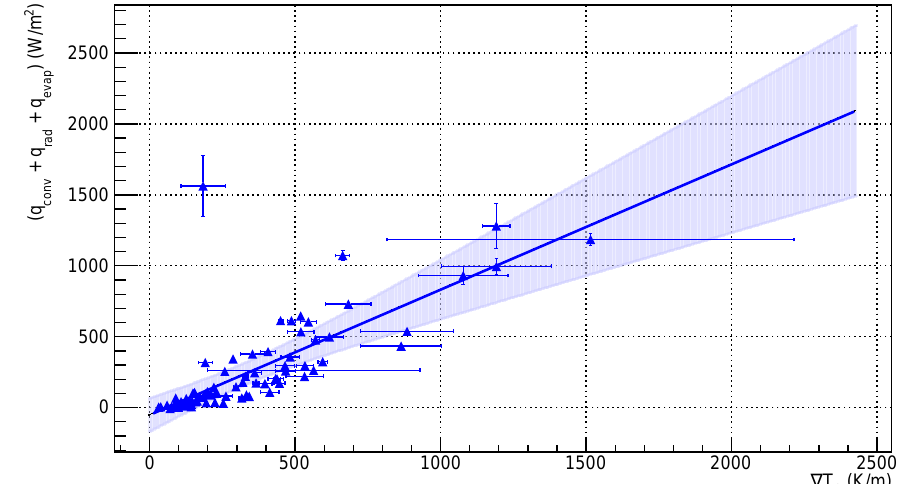
Figure 6. Plot of the total heat flux from the soil (convective, radiative and due to water evaporation), estimated from the measurement of the soil temperature, air temperature and humidity vs. the measured temperature gradient in the soil ( ∇ T s ). To avoid the effect of sun radiation, only measurements performed between 22:00 and 7:00 (local time) were selected. The line represents the best fit of q soil with a linear model: the angular coefficient is the thermal conductivity of the soil k soil . Results of the fit give a value of − 50 ± 30 W/m 2 for the a parameter in Equation (20) (congruent with 0 at 95% CL) and k soil = 0.88 ± 0.07 W / (K · m). Light blue band is the fit limits at 95%